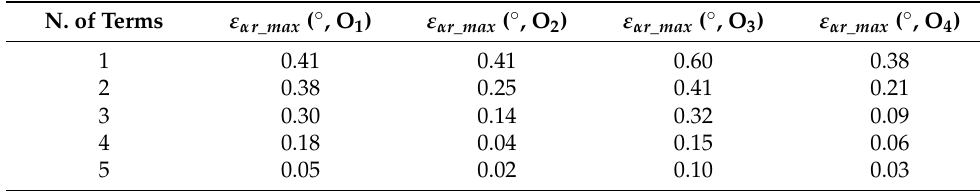
Table 5. Maximum polarization angle remaining errors ε α r after the application of each additive term to the ε α f functions.